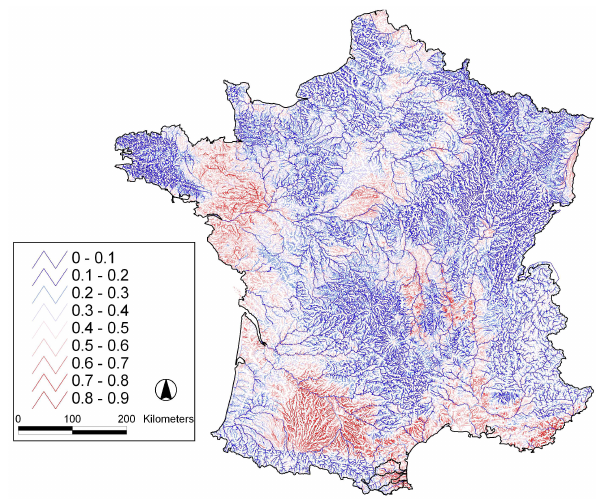
Fig. 9. Predictions of the probability of being intermittent made by the RF model of the flow-regime classification for the entire river network. Based on maximising Cohen’s kappa (Fig. 7), network segments whose probabilities are greater than 0.35 are intermittent and those less than 0.35 are perennial.